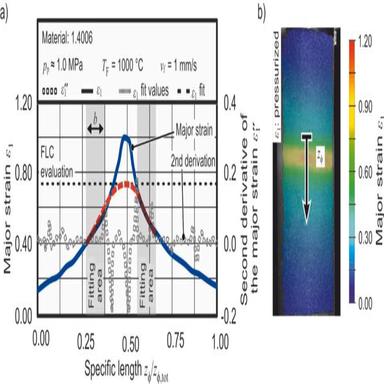
Definition of the evaluation points for the FLC from the pressurized-tube-tensile test a) Major strain over the meridian path zϕ and b) used DIC measurement in the last image before failure as well as the evaluation path.